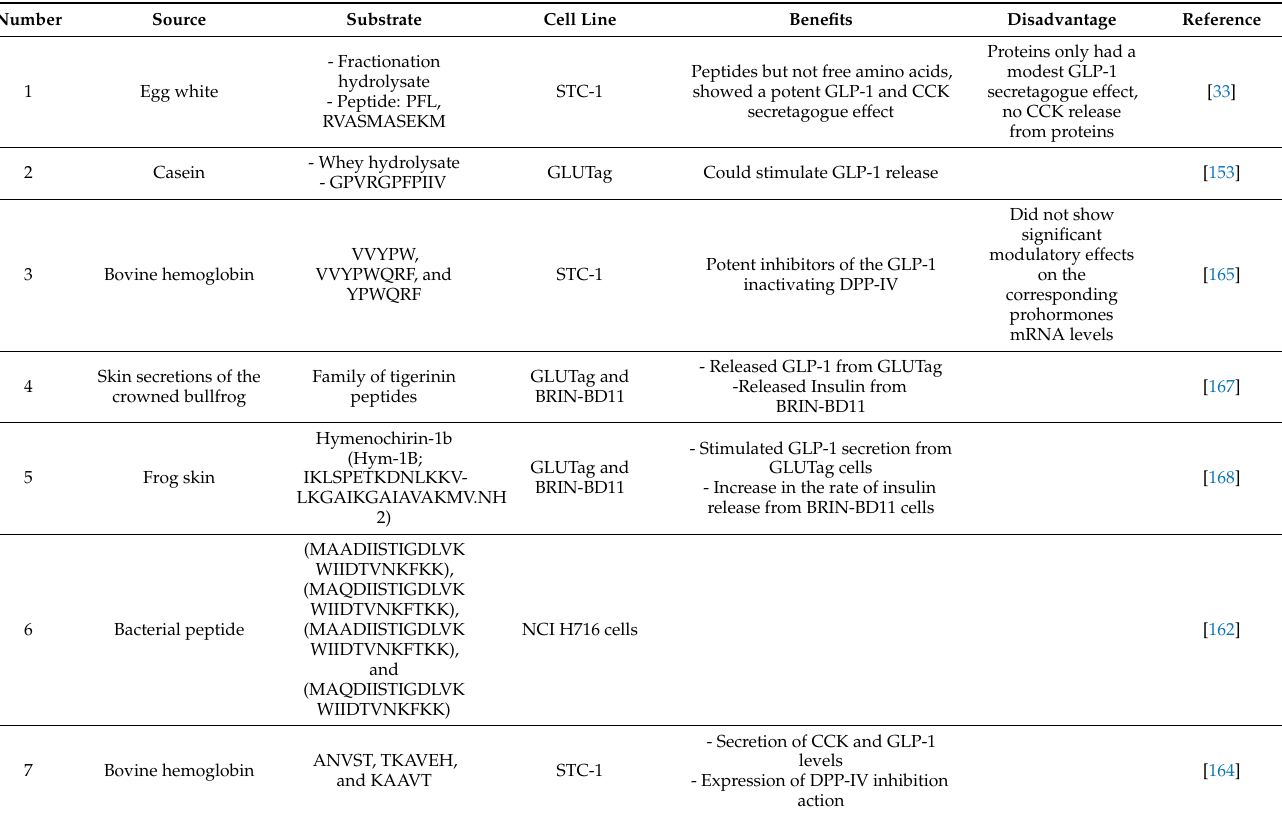
Table A4. In vitro studies on the glycemic regulatory effect of food-derived constituents with in vitro DPP-IV inhibitory